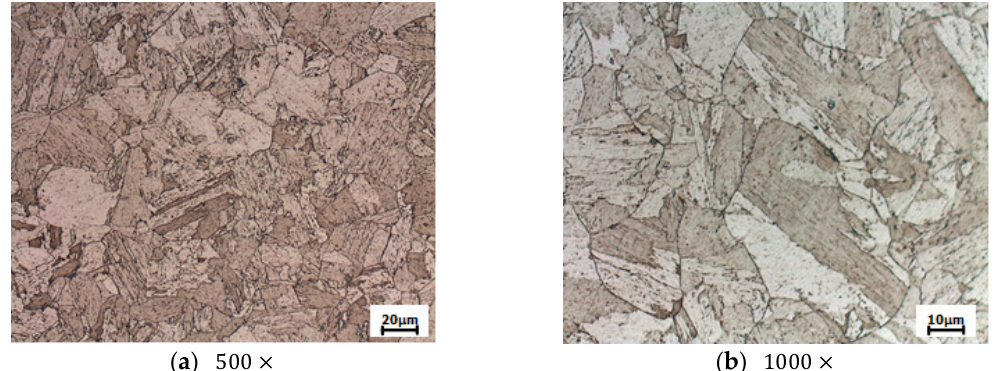
Figure 1. Optical microstructures of iron–nickel based ultra-high strength steel.